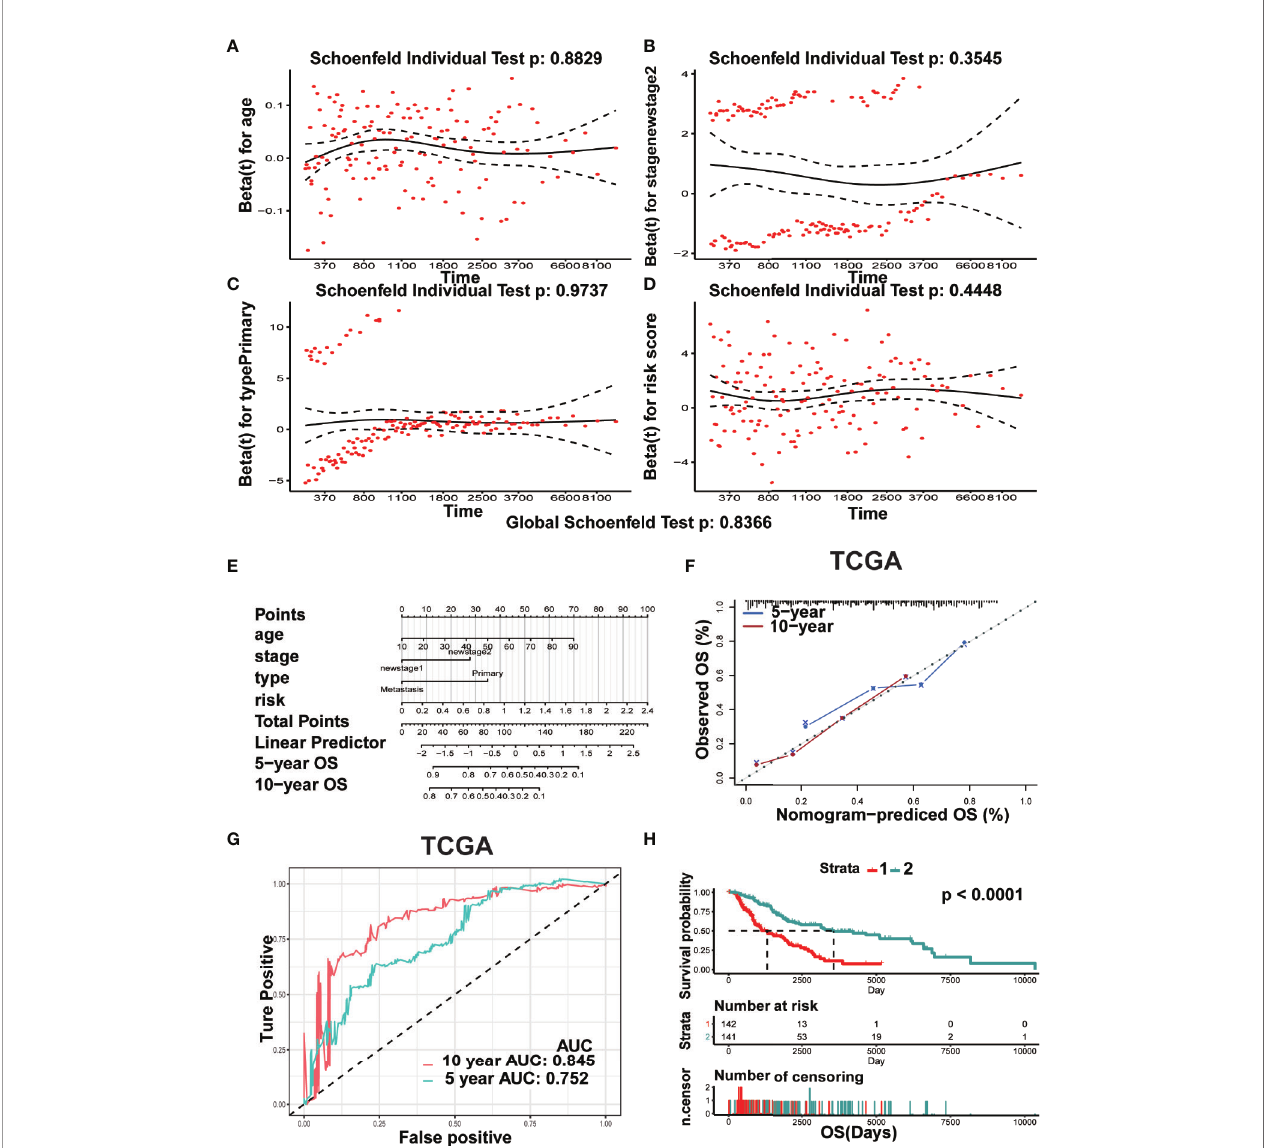
FIGURE 9 | Prognostic nomogram model was constructed for predicting OS. (A – D) The plots of Schoenfeld residual were showed for age (A) stage II (B) Primary (C) risk (D) in the prognostic nomogram. (E) The prognostic nomogram for melanoma patients was established dependent on four crucial factors. (F) The calibration curve of OS predicted by nomogram. The predicted possibility of OS is responded to x-axis and the observed OS is responded to the y-axis. (G) The curve of ROC based on the prognostic nomogram at 5-year and 10-year OS. (H) Comparison of OS between two groups (Strata 1 vs Strata